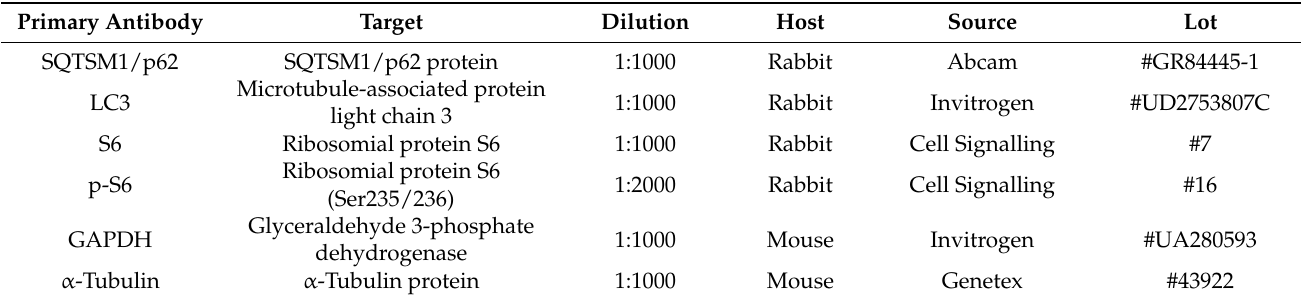
Table 1. Specifications of primary antibodies used in Western blotting